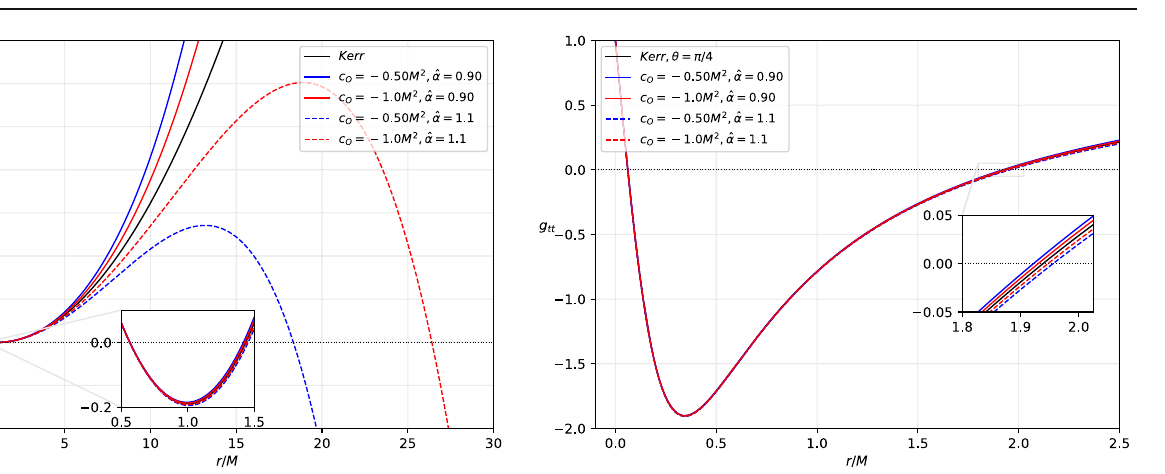
Fig. 1 Variations of the functions (cid:17) r (left panel) and g tt (right panel) withtheradialcoordinate r fortheblackholespinparameter a = 0 . 9 M . Theplotsshowthenullboundaries,withsolid(dashed)linesmimicking